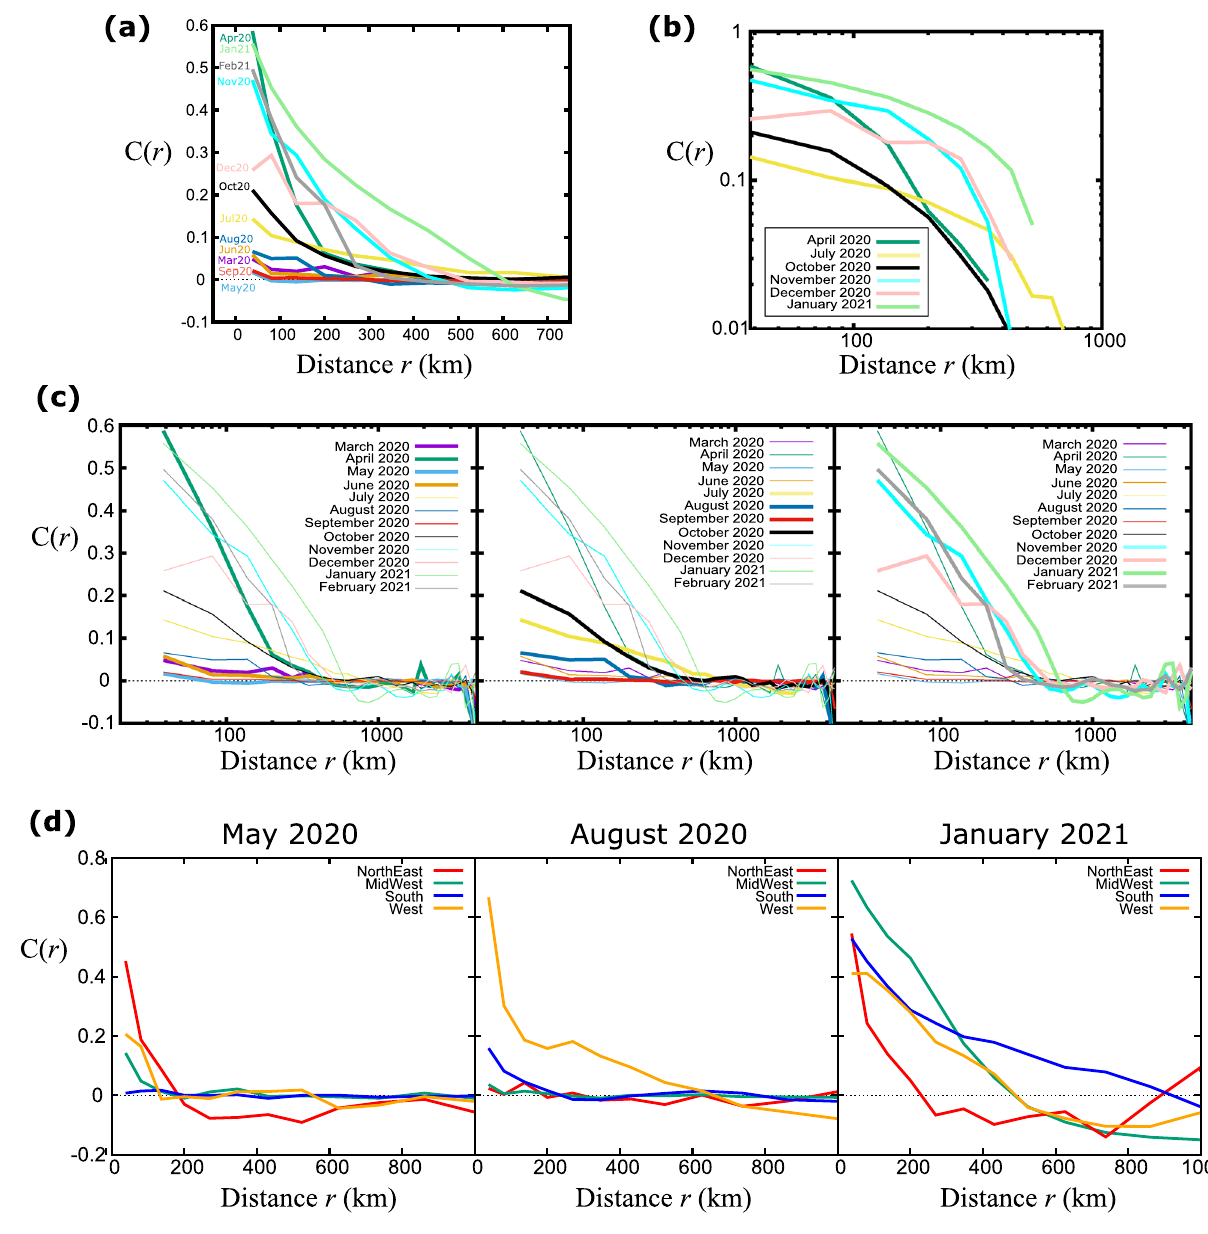
Figure 2. Decay of the correlation function with distance. ( a ) The correlation function as a function of the distance, averaged over all counties in the United States. Different curves correspond to different instances of time, for the first two weeks of the month from March 2020 to February 2020. ( b ) Same plot as in ( a ) in double logarithmic axes for select months. ( c ) For clarity, we split the plot in ( a ) into three different time intervals and focus on four months within these intervals. ( d ) Comparison of the correlation functions, averaged over all counties within the four US regions, for May 2020, August 2020, and January